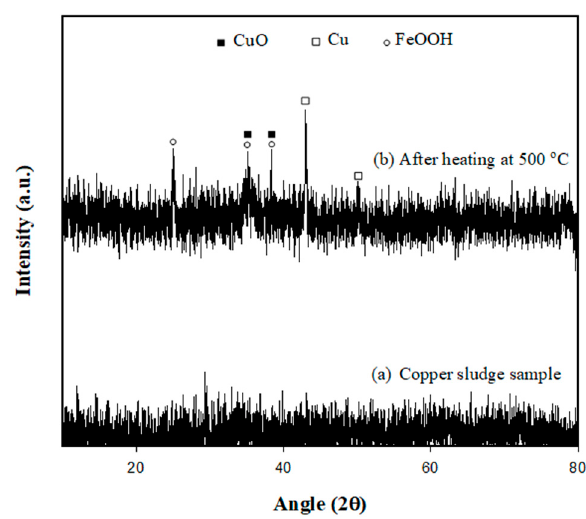
Figure 1. X-ray diffraction of the sludge sample before and after heating at 500 °C.